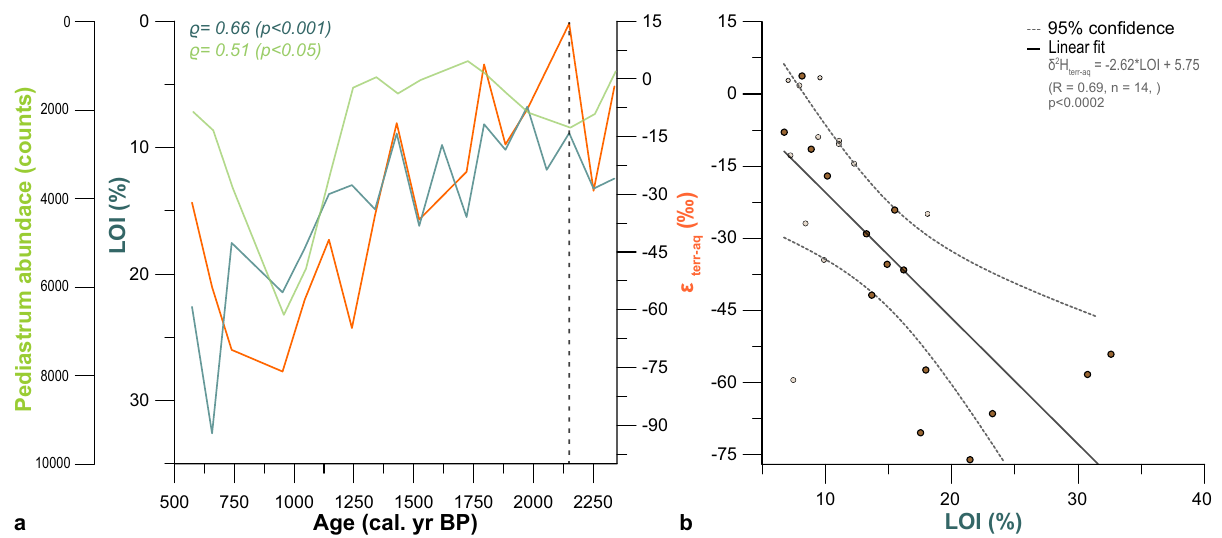
Fig. 7 Proxy-to-proxy calibration. a ε terr − aq and LOI values, as well as Pediastrum counts from ref. 60 in core LDP2 over the past two millennia (unit F3: see method s ) and b A bi-plot for this period that captures the association between these parameters with a linear regression fi t (opaque dots) and shows how data from the preceding 2.4 – 7 ka BP period covered by LDP2 (transparent dots) relate to this model (also see methods). For the latter purpose, we excluded values ( n = 7) from the ~2.4 – 2.7 ka BP to avoid closed-sum effects from dilution with alluvial clastic input during this time, as reported by ref. 29 .